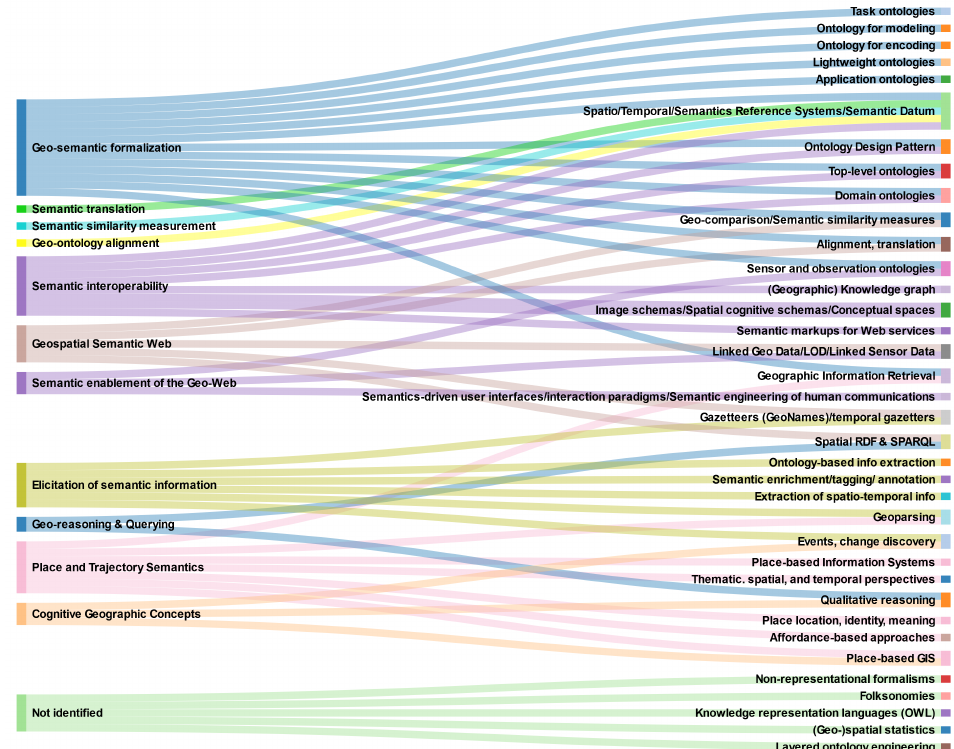
Figure 2. Diagram connecting keywords in geosemantics ( right ) and their categorization ( left ), as found in the reviews taken into